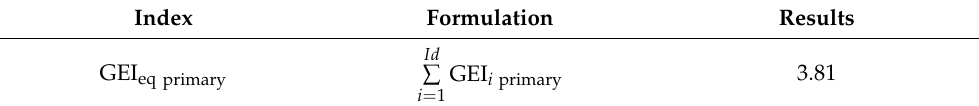
Table 5. GEI eq primary calculation for the second configuration.